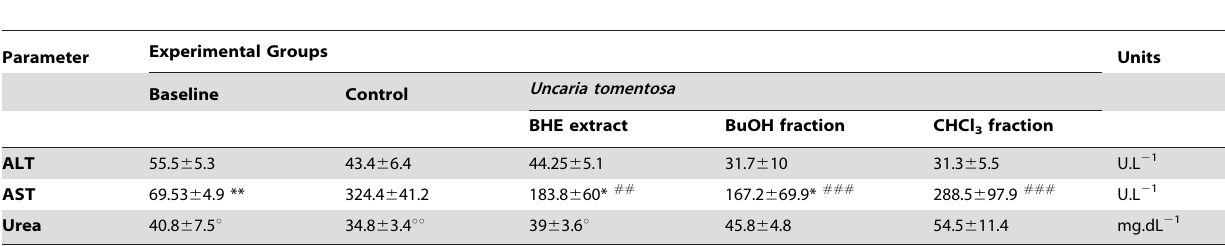
Table 1. Biochemical parameters measured in the plasma of Walker-256 tumour-bearing rats treated during 14 days with BHE U. tomentosa extract or its two fractions BuOH and CHCl 3 .